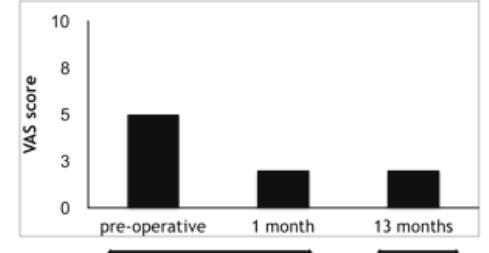
Figure 17: Significant decrease of VAS score over the follow-up.